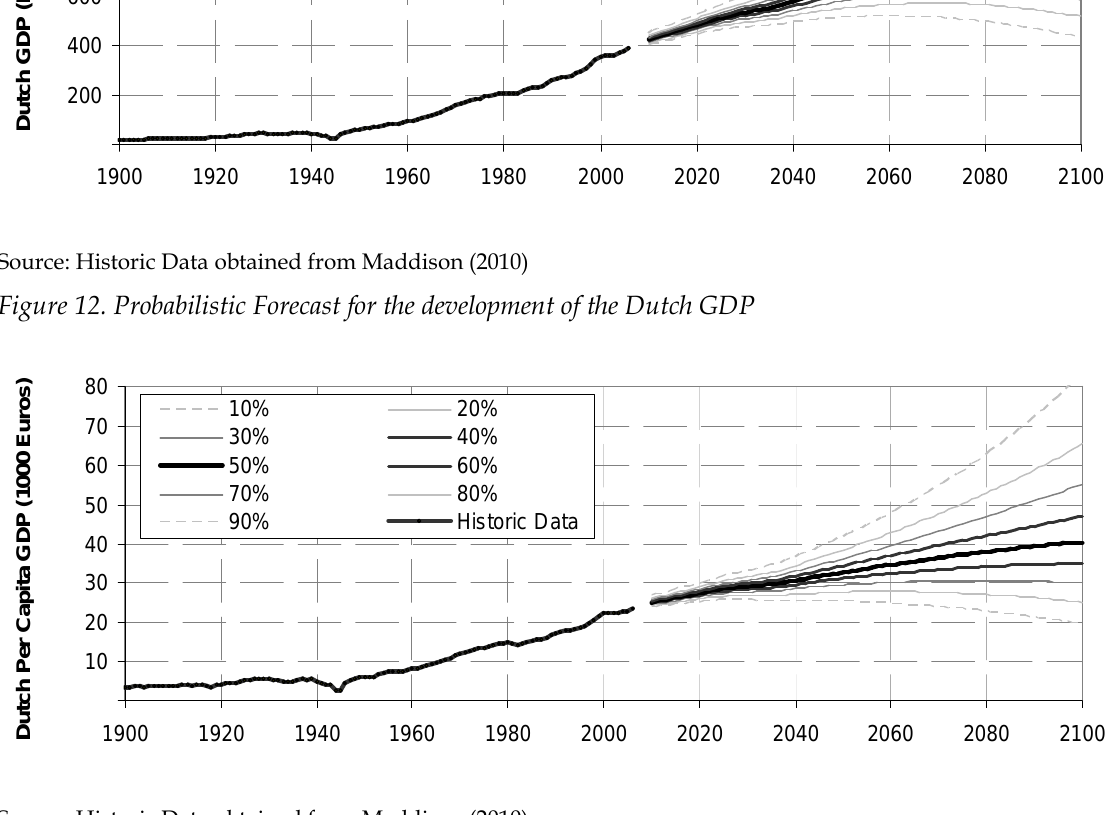
Figure 13. Probabilistic Forecast for the development of the Dutch GDP per Capita The forecast indicates that the GDP (and GDP per capita) growth will slow down over the next two decades as a result of the retirement of the baby boom generation. This effect cannot be fully compensated by an increase in labour productivity. After stabilisation of the labour outflow the GDP will further increase until the effect of total population decrease takes